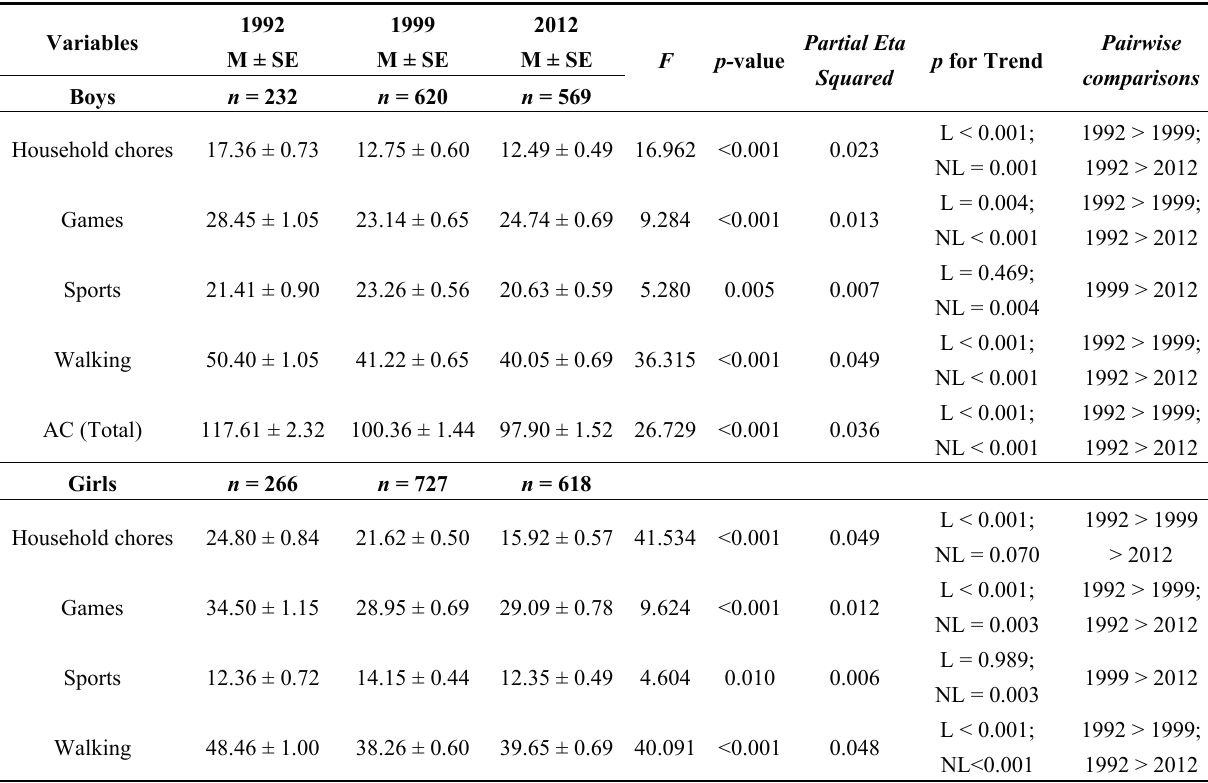
Table 2. Activity domain scores and total AC (adjusted for age, maturity status and BMI) for boys and girls (eight–15 years), by year of assessment, as well as pairwise